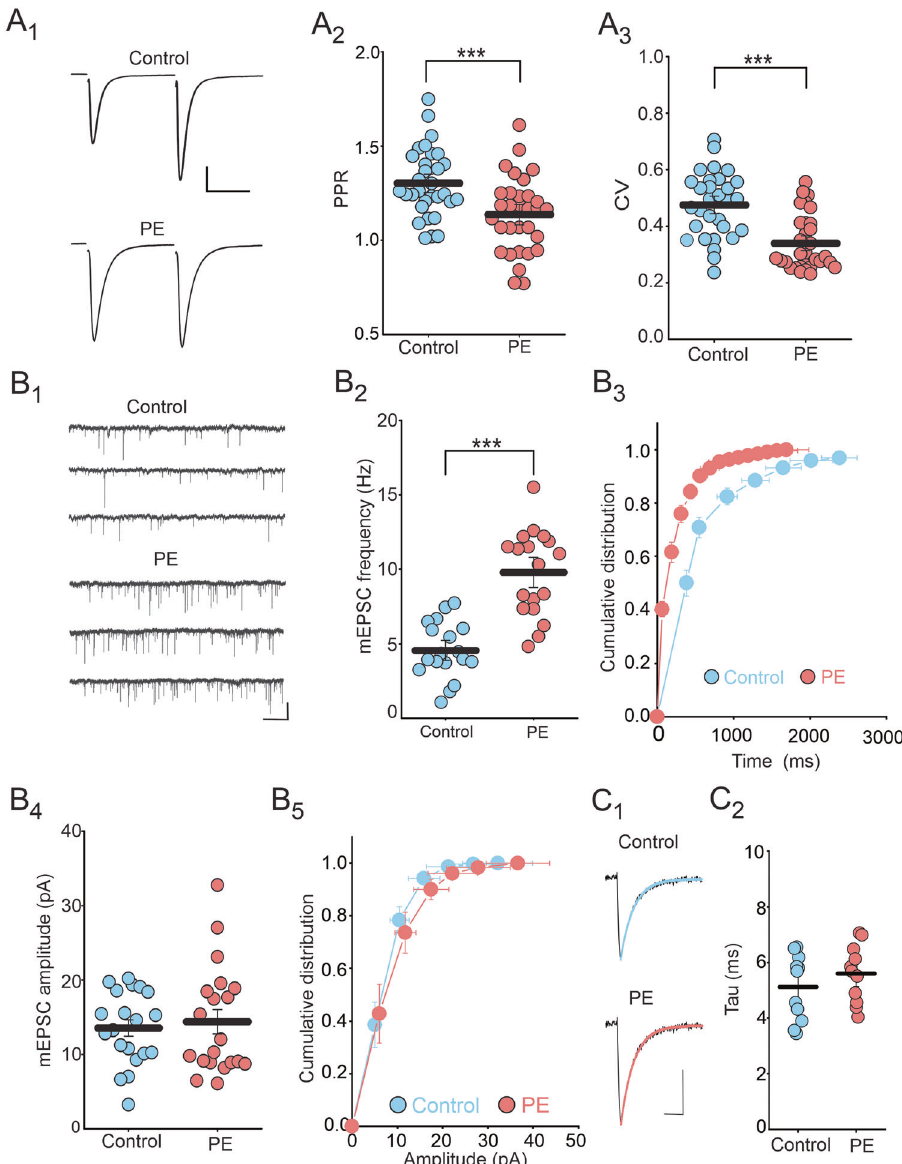
Fig. 3 Prenatal ethanol exposure increases glutamate release in the DRn. A PE decreases both the PPR and CV of EPSCs ( A 1 ) Representative pairs of EPSC traces (average of 60 consecutive trials) evoked by paired stimuli (50 ms interval) in control (left trace) and in PE rats (right trace). ( A 2 ) Summary plot of the PPR magnitude of EPSCs obtained in control ( , n = 31, N = 11 from 5 litters) and in PE rats ( , n = 31, N = 11 from 5 litters, independent-samples t-test: p < 0.001). A 3 Summary plot of the CV of EPSCs in control ( , n = 32, N = 11 from 5 litters) and PE rats ( , n = 32, N = 11 from 5 litters, Mann-Whitney test: p < 0.001). ( B ) PE increases the frequency, but not the amplitude of mEPSCs. B 1 Representative current traces recorded from control (upper traces) and PE rats (lower traces). B 2 Scatter plots of the average mEPSC frequency recorded in control ( , n = 18, N = 6 from 3 litters) and PE rats ( , n = 18, N = 6 from 3 litters, independent-samples t-tests: p < 0.001). B 3 Cumulative distribution of mEPSC frequency obtained in control and PE rats ( n = 18, N = 6 from 3 litters, K-S test: p < 0.05). B 4 Scatter plots of the average mEPSC amplitude recorded in control ( , n = 20, N = 7 from 4 litters) and PE rats ( , n = 20 , N = 7 from 4 litters, independent-samples t-tests: n = 20, N = 7 from 4 litters, K-S test, p > 0.05). p > 0.05). B 5 Cumulative distribution of mEPSC amplitude obtained in control ( ) and PE rats ( ) ( C PE has no effect on the decay kinetic of mEPSCs. C 1 Averaged mEPSC traces (100) fi tted with single exponential decay function and recorded from control (upper traces) and PE rats (lower traces). Scale bars: 5 pA, 5 ms. C 2 Averaged decay time constant of mEPSCs obtained in control ( ) and PE rats ( ) ( n = 11, N = 5 from 3 litters, independent-samples t-tests: p > 0.05). n = number of cells, N = number of rats. found in control rats, administration of NO donor SNAP (200 µM) signaling and persistent activation of soluble guanylate cyclase potentiated the eEPSC amplitude (143.96 ± 10.90 % of baseline; and protein kinase G (sGC/PKG) signaling cascade, then due to Fig. 5A 1 ), and increased glutamate release, as indicated by the an occlusion effect, direct activation of this signaling pathway should not potentiate eEPSC amplitude in PE rats. We tested this decrease in PPR (Baseline: 1.21 ± 0.08; SNAP: 1.11 ± 0.08; possibility by conducting three independent sets of experi- Fig. 5A 2 ) and CV (Baseline: 0.45 ± 0.04; SNAP: 0.30 ± 0.02; ments. First, we examined the effect of NOS activation on the Fig. 5A 3 ). In contrast, administration of SNAP (200 µM) did not amplitude of eEPSCs in control and PE rats. As expected, we alter the eEPSC amplitude in PE rats (100.64 ± 3.91 % of baseline; Translational Psychiatry (2022)